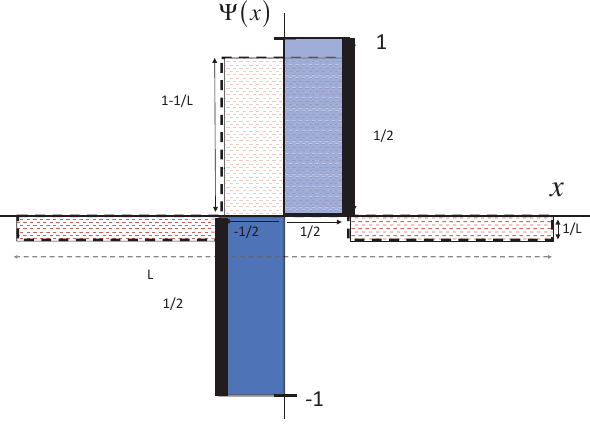
Fig. 3. This shows the “poor man’s wavelet” by black bars repre- senting the amplitudes of Dirac δ functions, (the basis of the usual difference structure function, valid for 0 < H < 1; this is only sym- bolic since the true δ function amplitude is of course infinite), the Haar wavelet (the basis of the Haar structure function, uniform blue shading, the second difference of the running sum, valid for − 1 < H < 1), and the wavelet used for the “tendency” structure function (valid for − 1 < H < 0), stippled